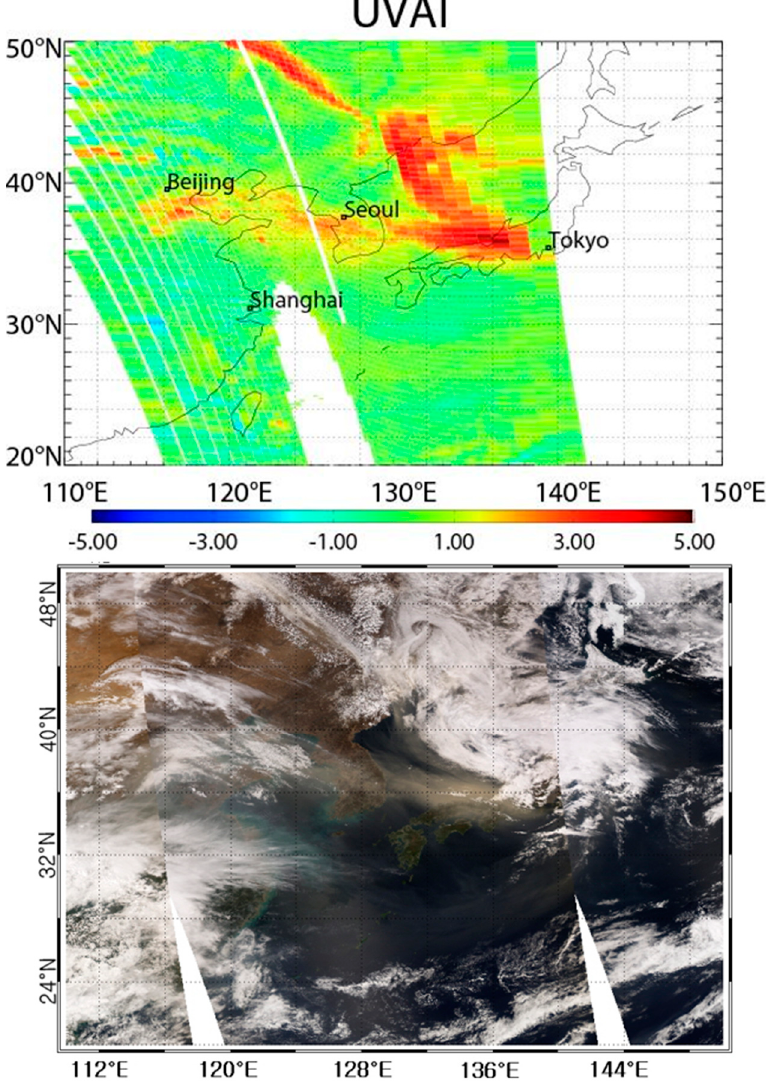
Figure 2. A single path of OMI UVAI data is projected for all OMI data for the Korean Peninsula and surroundings ( top ). MODIS True Color image ( bottom ) with an 8 min time difference compared with OMI, showing a severe dust storm over the Korean Peninsula, which originated in north China. Highly absorbing aerosols within the dust storm were detected by OMI UVAI with values greater than 1.5.